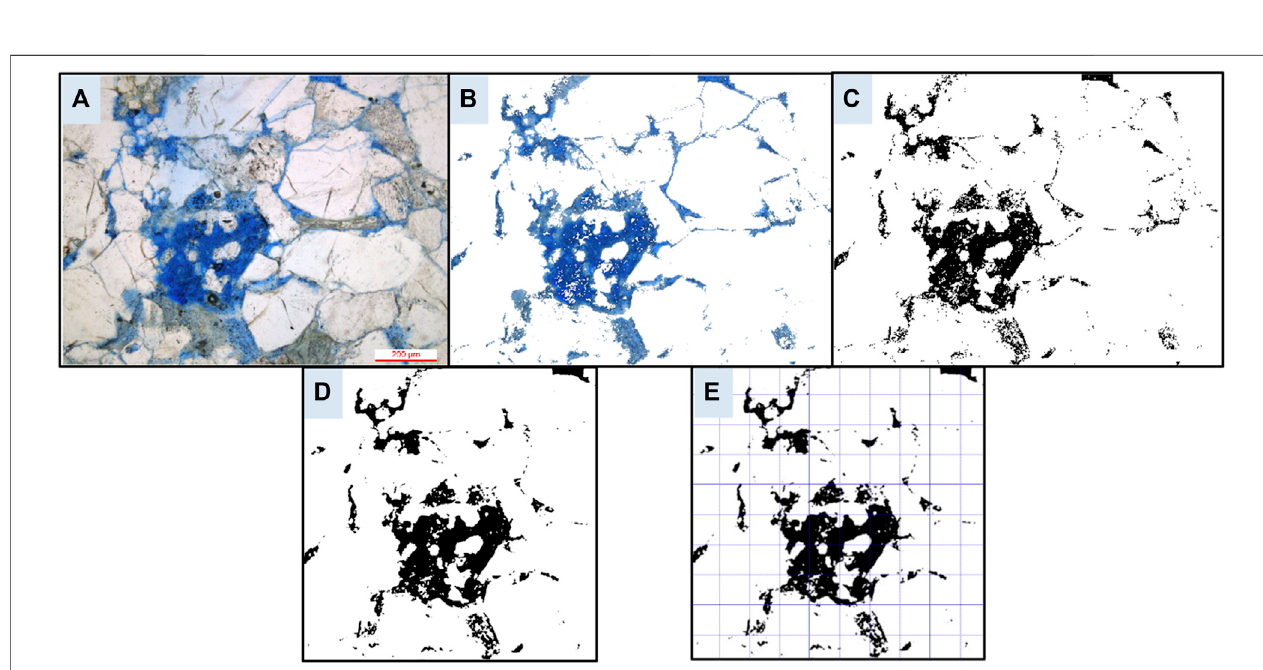
FIGURE 2 | (A) The original casting thin section image; (B) Extracted pore structure; (C) Binarised image of pore structure; (D) Cropping the binary image of pore structure into square-shaped for fractal analysis; (E) Fractal analysis on pore structure using the box counting method.